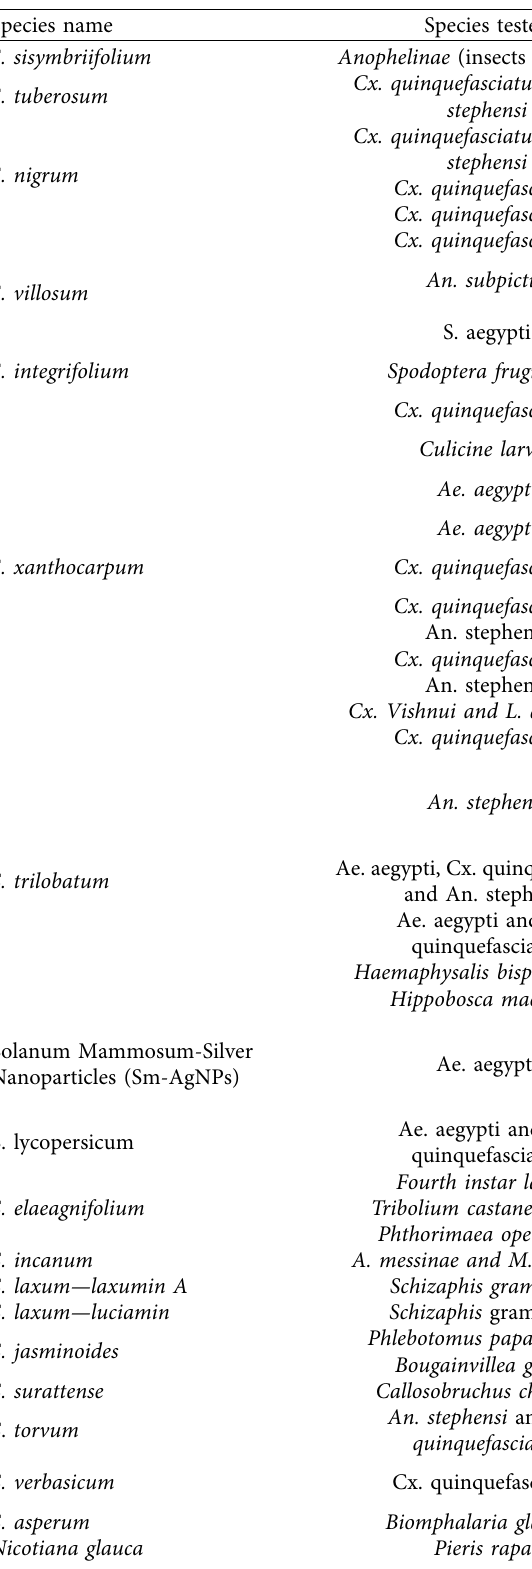
Table 4: Different types of test organisms, bioassays, and doses used to study the mosquitocidal activity of crude plant extracts from Solanum